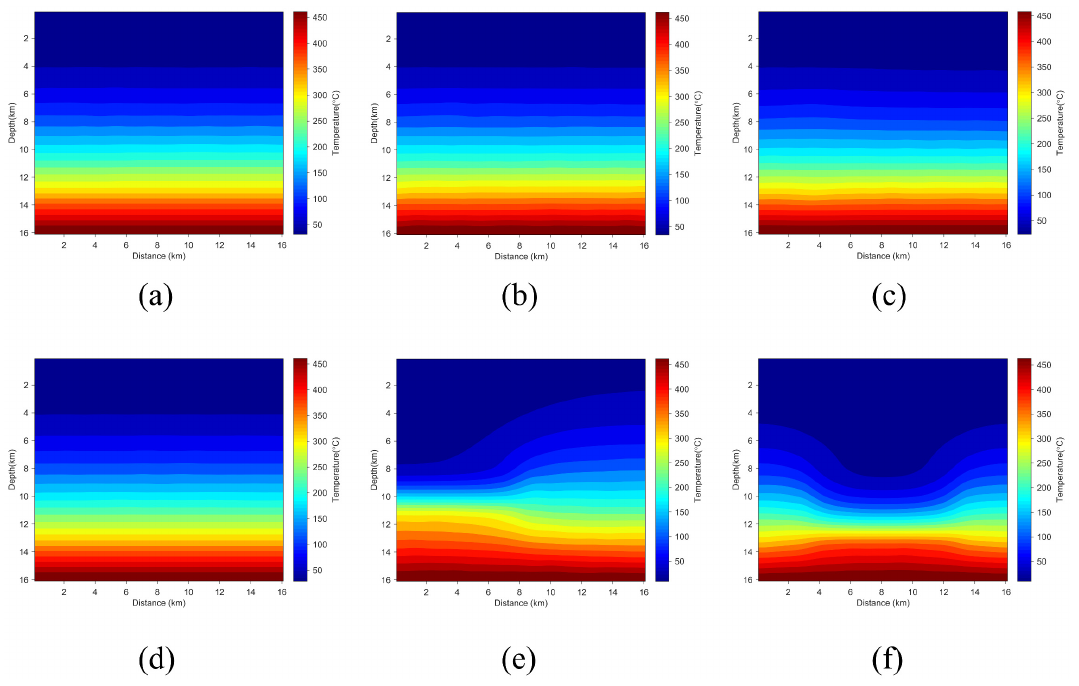
Figure 7. The temperature field labels of six geological models ( a – f ) from the training data set. ( a ) Temperature field of Graben model, ( b ) temperature field of pleated − structure model, ( c ) tempera- ture field of magmatic intrusion model, ( d ) temperature field of platform model, ( e ) temperature field of magmatic intrusion model, ( f ) temperature field of magmatic intrusion model. The finite element method was used to simulate the heat conduction of the model, the temperature field after 100,000 years was simulated, and the label was established.